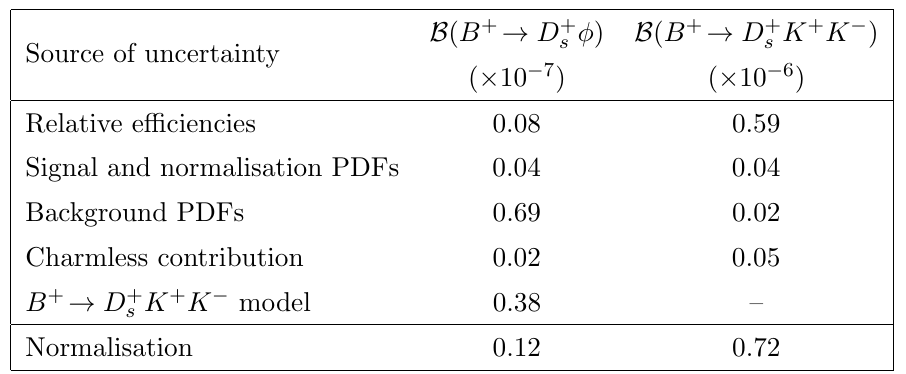
Table 3. Systematic uncertainties contributing to the measurements of B ( B + ! D + B ( B + ! D + K + K (cid:0) ). The systematic uncertainty from the normalisation branching fraction is s also